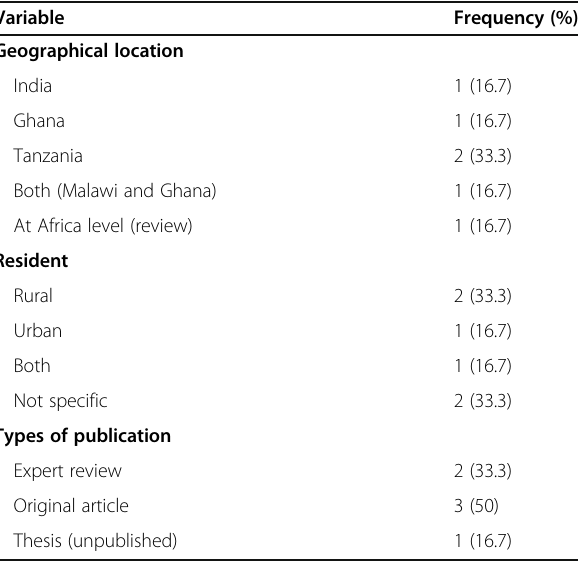
Table 1 Summary of the main features of the 6 studies included in the scoping review on the applications of electronic technologies for treatment outcome, case detection, and disease management